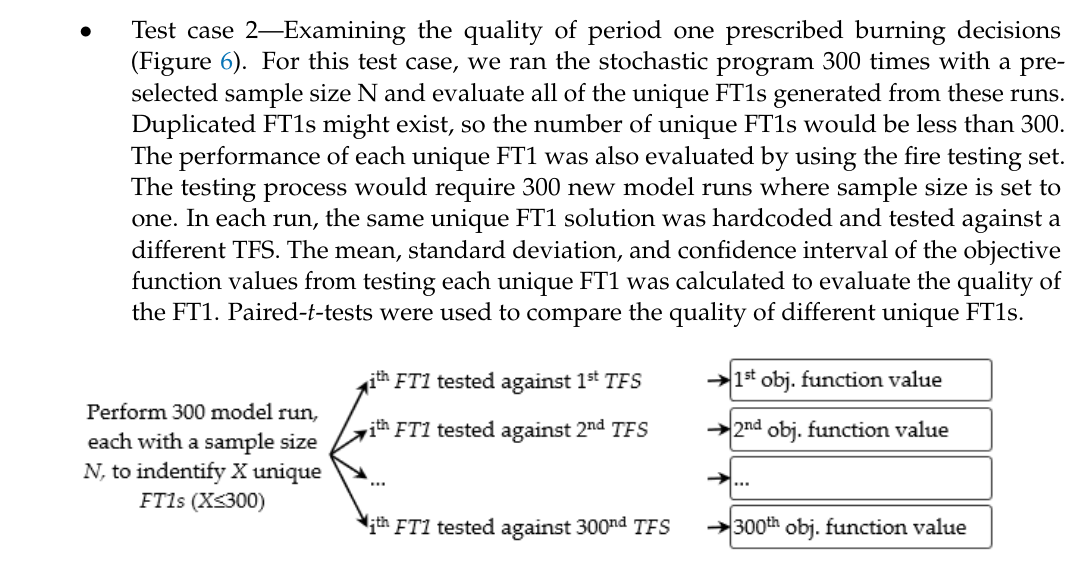
Figure 5. The process to evaluate the overall quality of the first period prescribed burning decisions (FT1s) generated by the stochastic program using a specific sample size N.